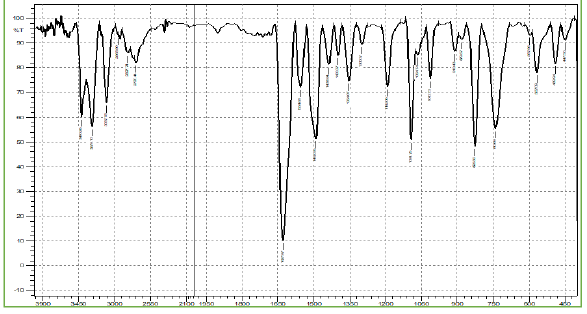
Fig. 2. IR spectrum of palladium complexes of 2-Amino 4-(4-Chloro- phenyl)thiazole